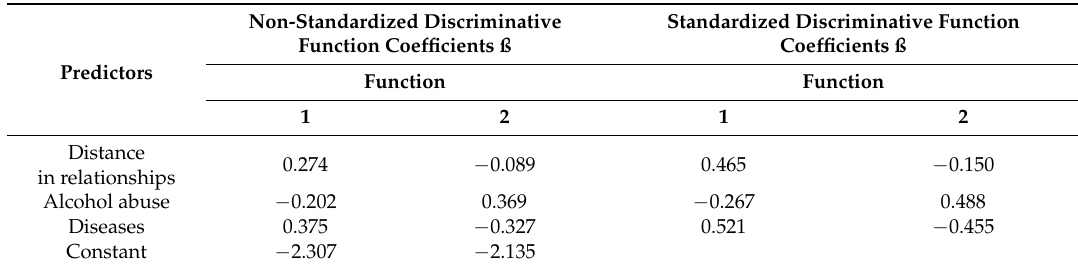
Table 3. Family risk factors of destructive behaviors-a discriminant